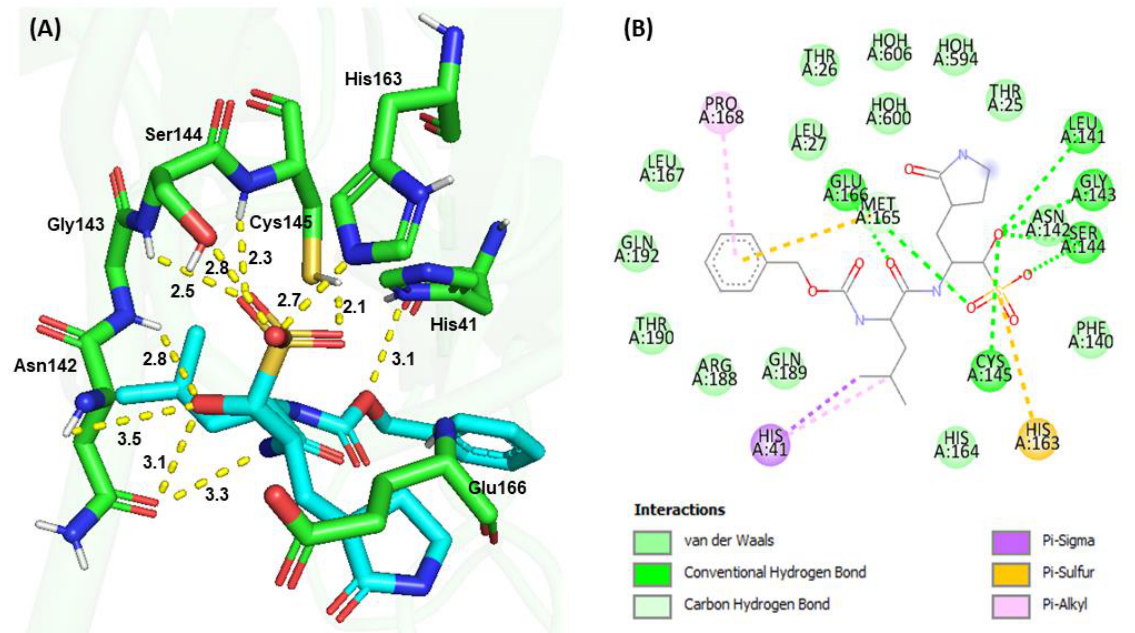
Figure 5. Molecular docking of GC376 and SARS-CoV-2 M pro . ( A ) 3D interactions between GC376 (Cyan) and M pro (Green). ( B ) 2D interactions, including H-bonding, hydrophobic, π− sulfur, π−π , and π− alkyl interactions between GC376 and M pro , identified by Discovery Studio.